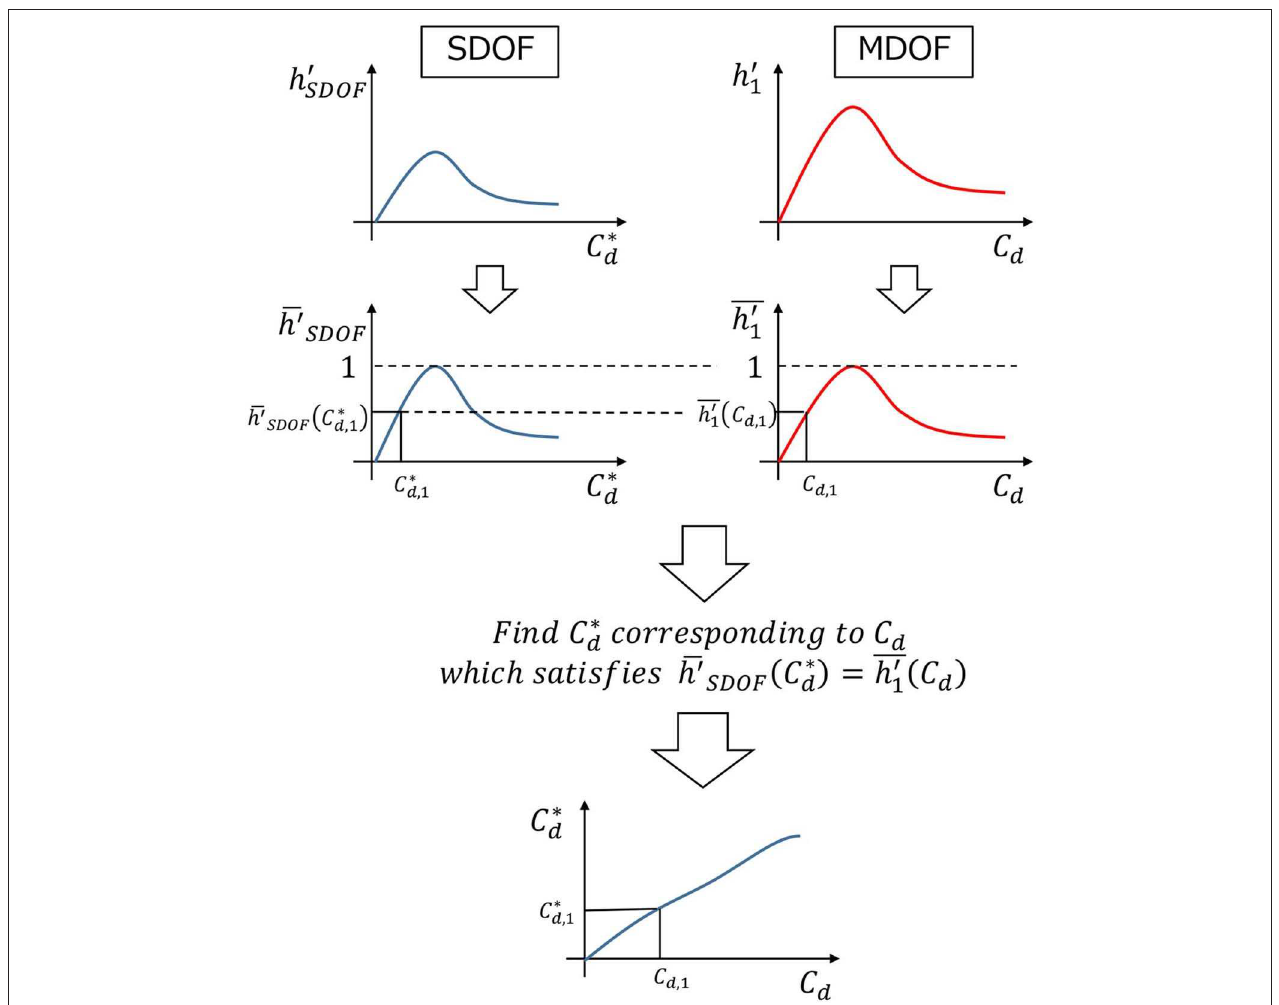
FIGURE 4 | Computation flow of damping coefficient of viscous damper in equivalent SDOF model.